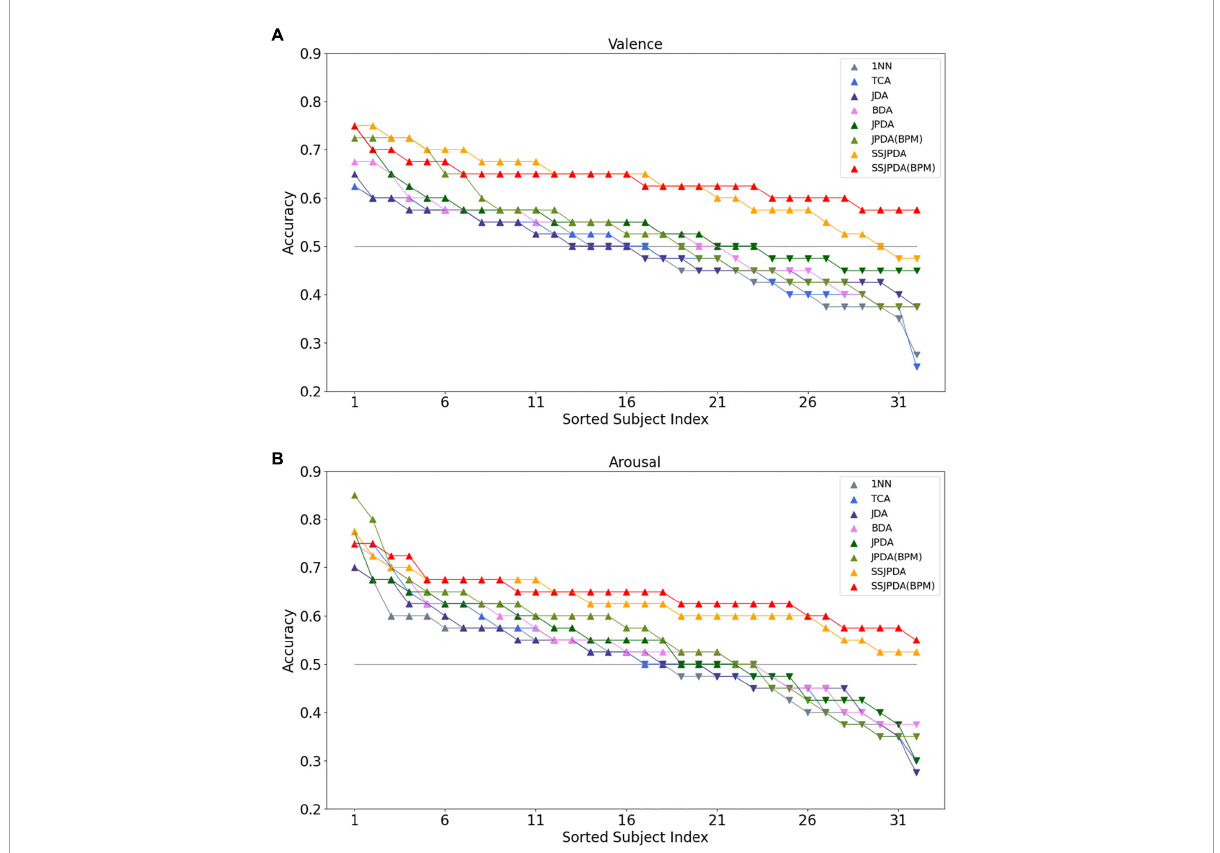
FIGURE2 The recognition accuracy of each algorithm in Experiment 2 in 32 subjects was ranked in descending order. (A) Shows the recognition accuracy of valence in different algorithms of 32 subjects, and (B) shows the recognition accuracy of arousal in different algorithms of 32